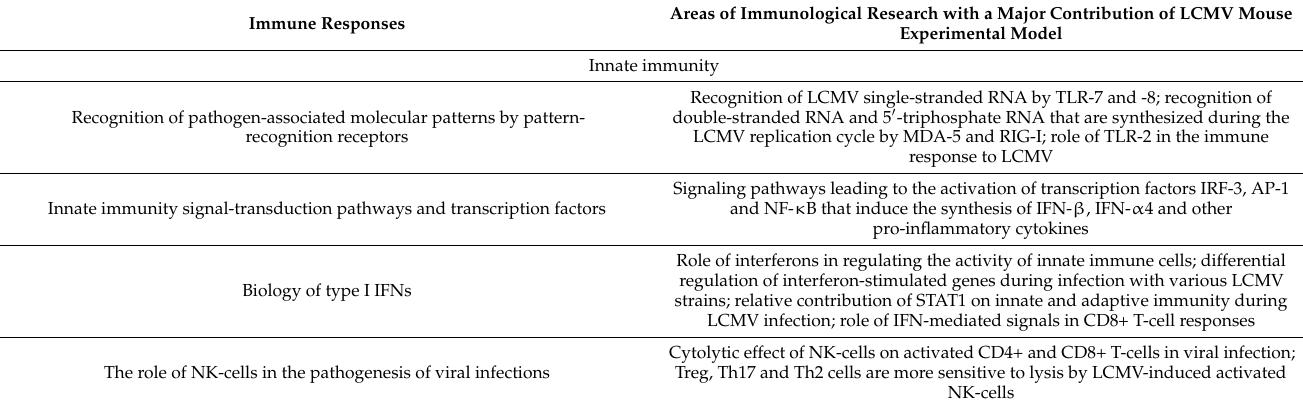
Table 3. Selected recent contributions of LCMV mouse model to immunological research. Immune